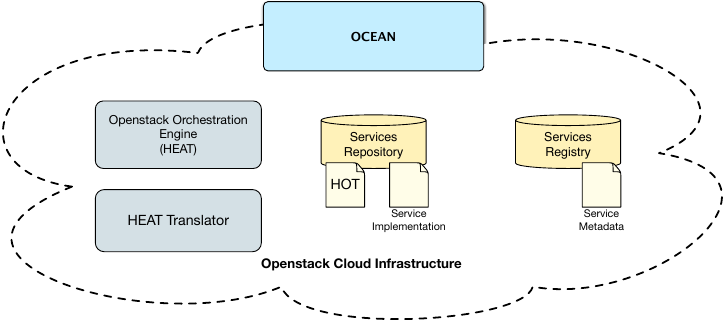
Figure 13. OpenStack-based OCEAN